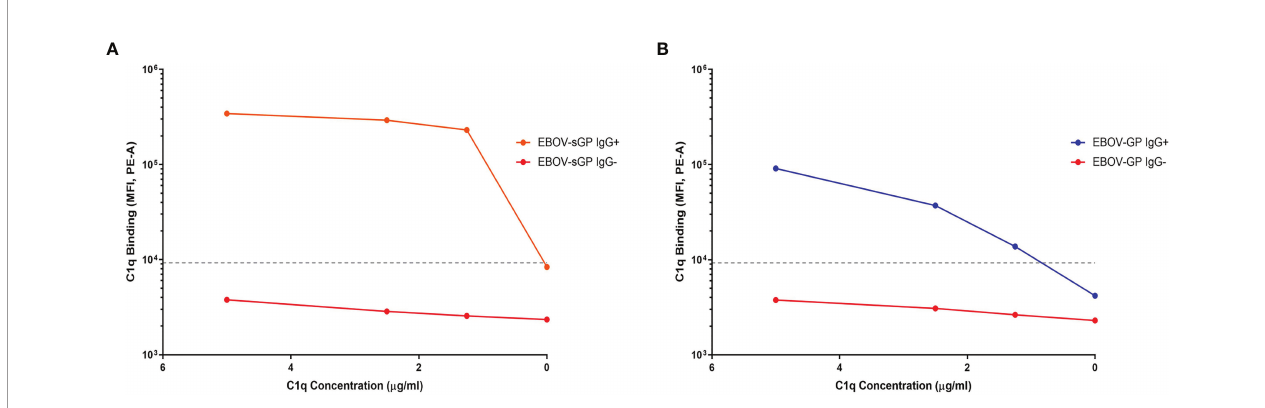
FIGURE 3 | The binding of puri fi ed C1q protein to EBOV-GP and EBOV-sGP in antibody complexes. Puri fi ed C1q protein was titrated against EBOV-GP (A) and EBOV-sGP (B) conjugated beads with human plasma in the presence or absence of EBOV-GP IgG. A negative cut-off (grey dotted line) was determined using the mean value for all control samples where the primary antibody was excluded, plus three